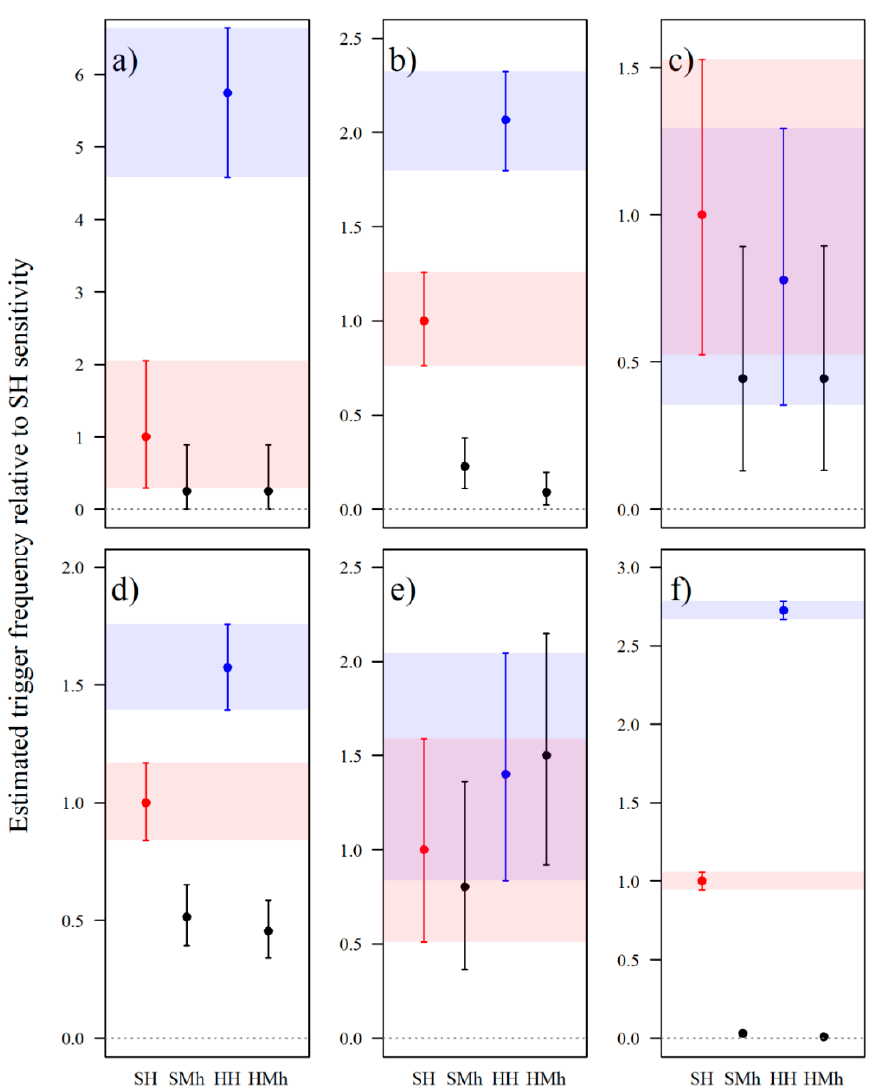
Figure 6. Estimated trigger frequencies as a function of passive infrared (PIR) sensor sensitivity for six groups, relative to the standard PIR sensor set to ‘High’ (SH, red). Groups are: ( a ) small lizards; ( b ) medium–large lizards; ( c ) snakes; ( d ) small mammals; ( e ) medium–large mammals; and, ( f ) false triggers. Passive infrared sensitivity levels are: SH, standard sensor set to ‘High’; SMh, standard sensor set to ‘Medium / High’; HH (blue), high-sensitivity sensor set to ‘High’; HMh, high-sensitivity sensor set to ‘Medium / High’. Central dots represent the mean of the posterior distributions and bars represent 95% credible intervals.